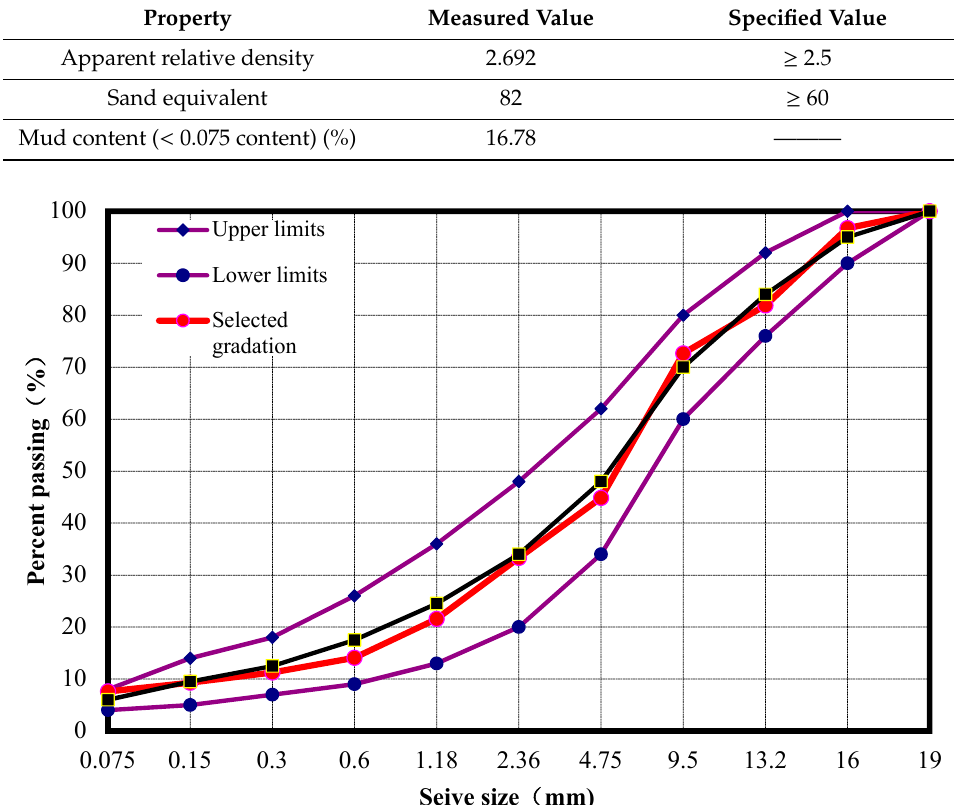
Figure 1. Asphalt concrete (AC-16) gradation design selected in the experiments.